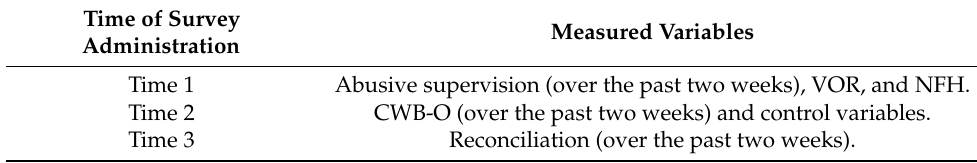
Measured Variables